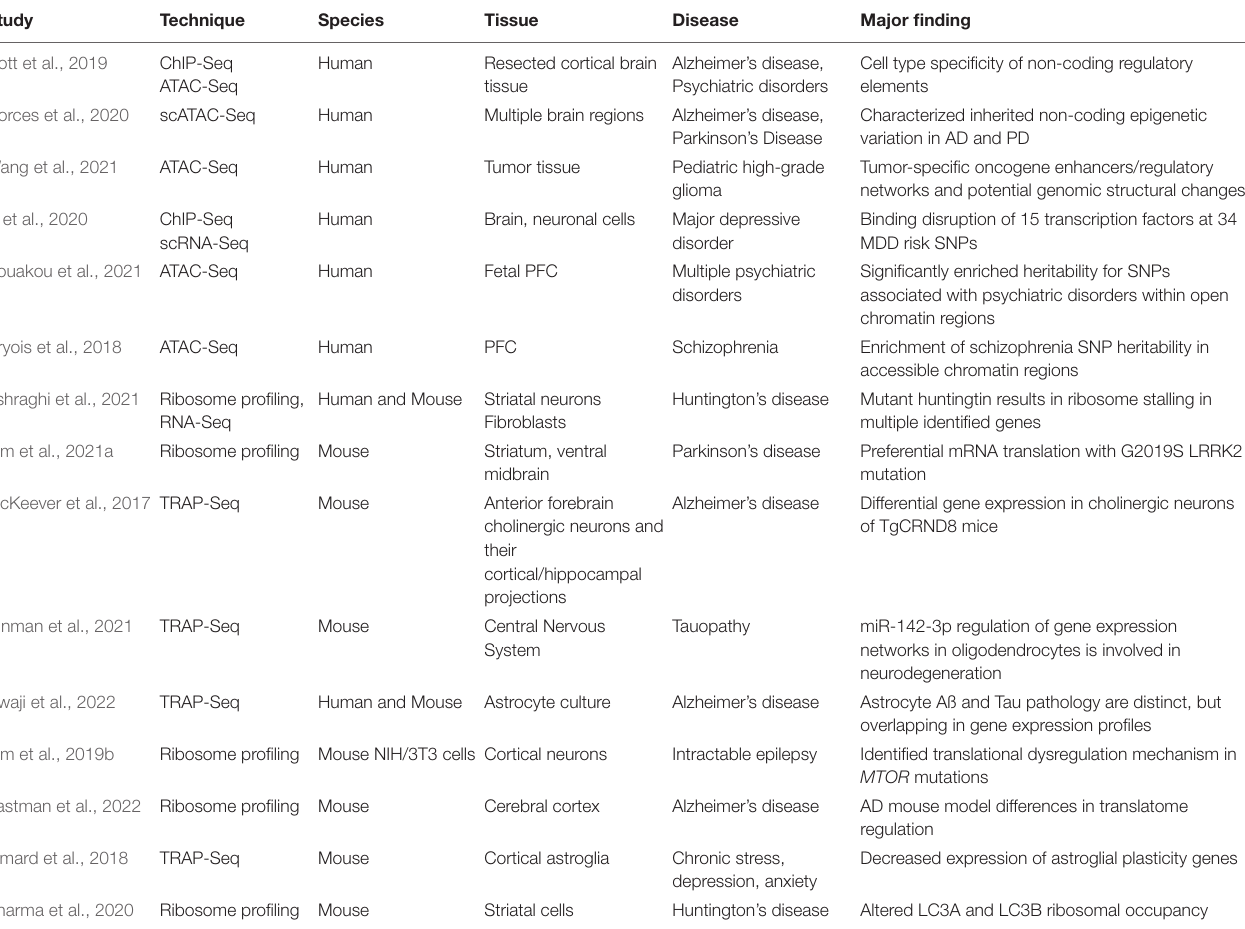
TABLE 3 | A selection of studies using translatomic and epigenomic methods to study brain function and